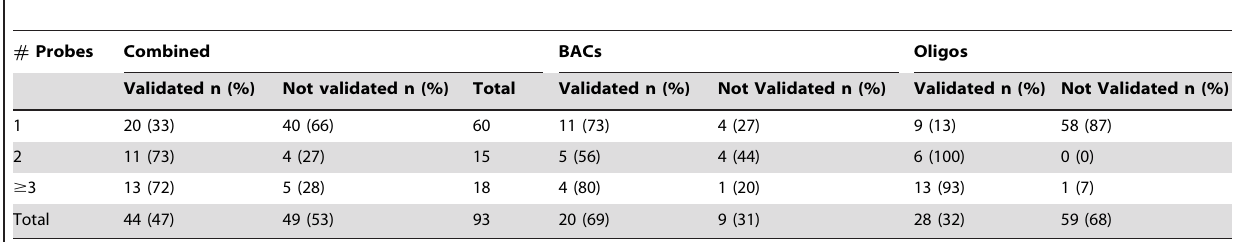
Table 2. Validation of CNV changes identified in HapMap populations using different aCGH